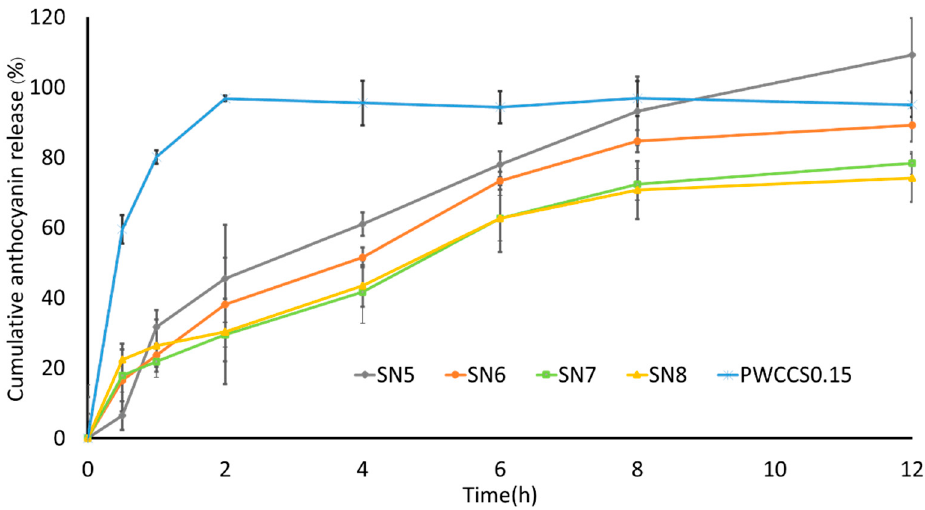
Figure 6. The release profiles of 0.15% w / v PWCC extract solution (PWCCS0.15) compared with sericin hydrogels (SN5–SN8) contained 0.15% PWCCS.